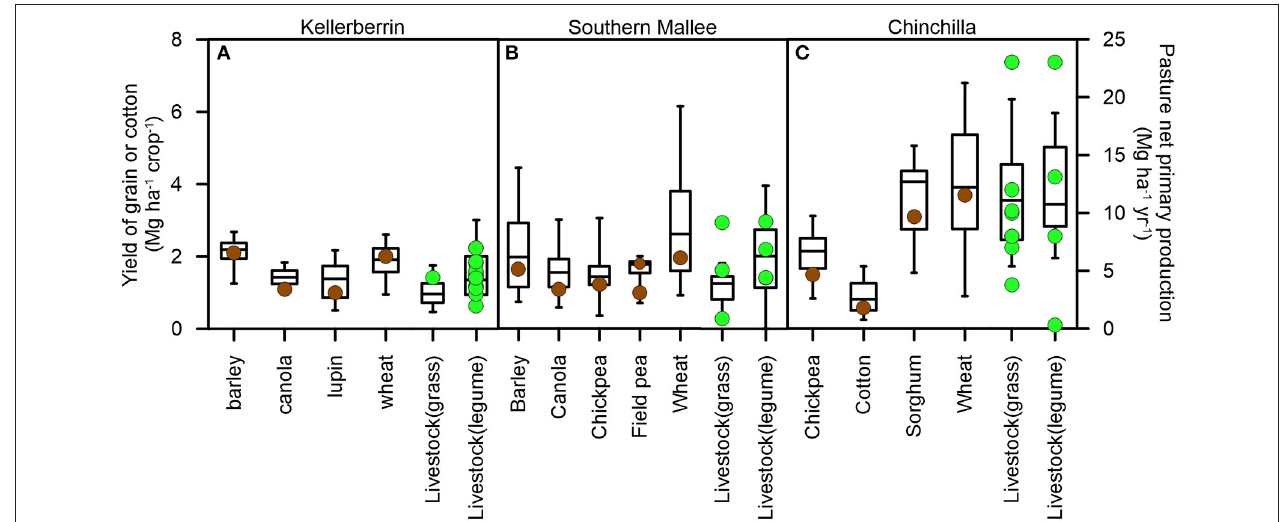
FIGURE 3 | Simulated (box and whiskers plots) and reference crop (brown symbols) and pasture yields (green symbols) at the (A) Kellerberrin, (B) Southern Mallee, and (C) Chinchilla case study farms. Permanent pastures consist of grass receiving 12.5–50kg N fertilizer ha − 1 yr − 1 (Livestock grass scenario) and a legume pasture that was not fertilized with N (Livestock legume scenario). Reference yields for crops represented typical crop yields at the farm as described by the farm owners. Reference yields for pastures were sourced from the literature as follows: for Kellerberrin, Puckridge and French (1983), Bolger and Turner (1999), Latta et al. (2001), Fillery and Poulter (2006), Brennan et al. (2013); for Southern Mallee, Puckridge and French (1983), Descheemaeker et al. (2014); for Chinchilla, Lloyd (1981, 2007), Lloyd et al. (1983), Cook et al. (2005). “Whiskers” in the box and whisker plots are provided for 5 and 95% of simulated values.